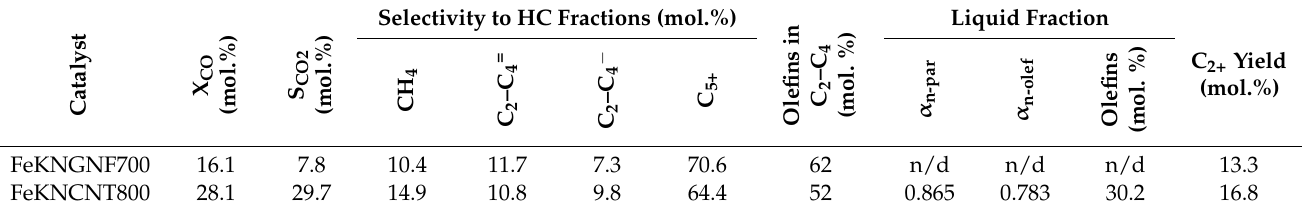
Table 1. Conversion and selectivity data for FeKNGNF700 and FeKNCNT800 catalysts in FTS (20 bar, 300 ◦ C, 5 NL/g cat /h, CO:H 2 =